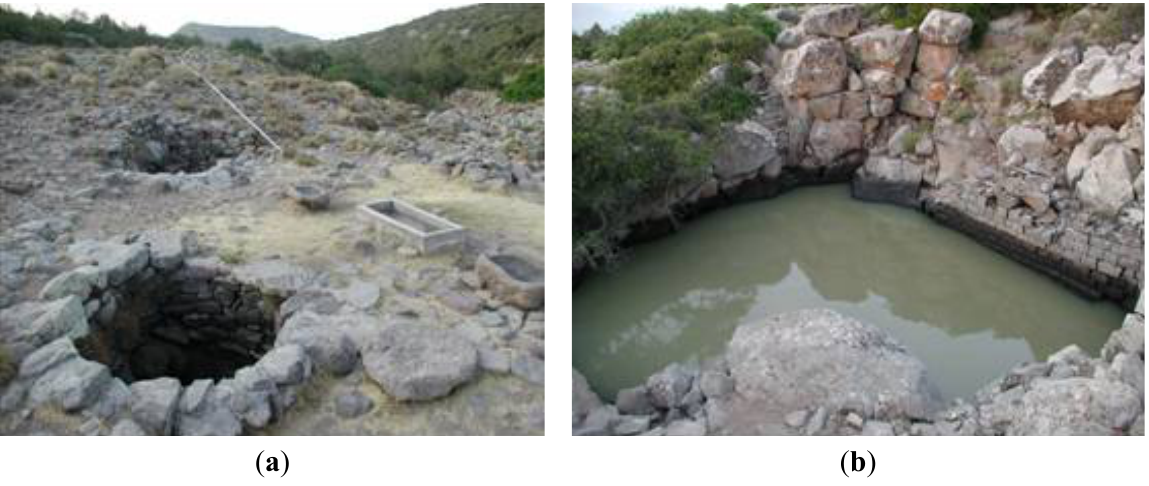
Figure 2. ( a ) Rural rainwater cisterns at Mpourdechtis area and ( b ) The main cistern at the